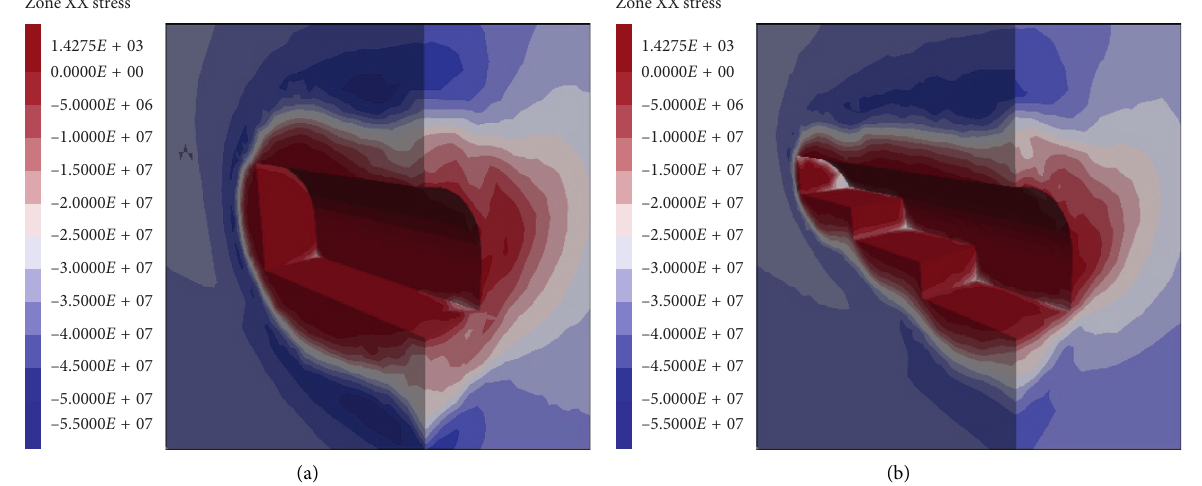
Figure 11: Horizontal stress of stepped driving. (a) Nonstepped driving. (b) Stepped driving.